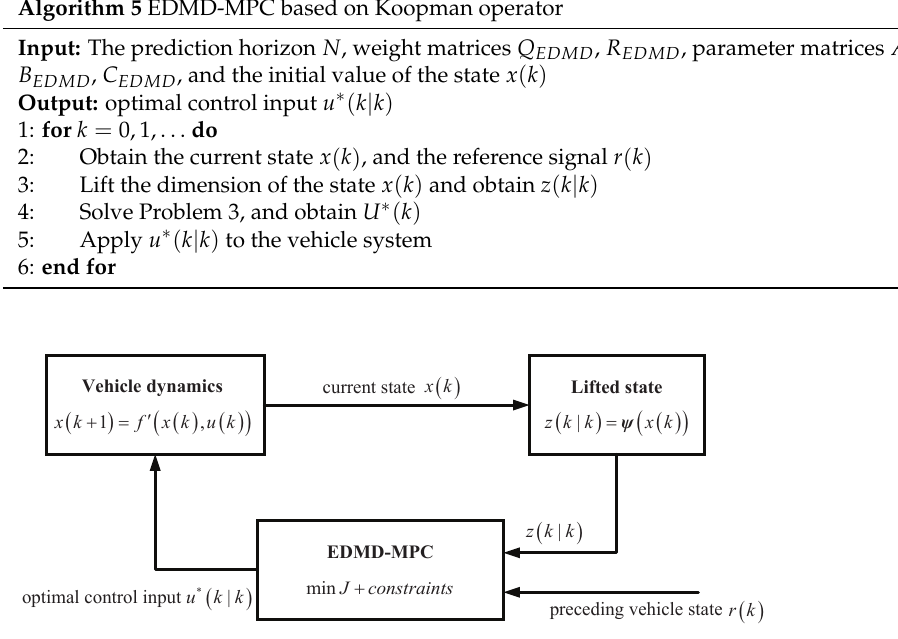
Figure 7. Control diagram of EDMD-MPC based on the Koopman